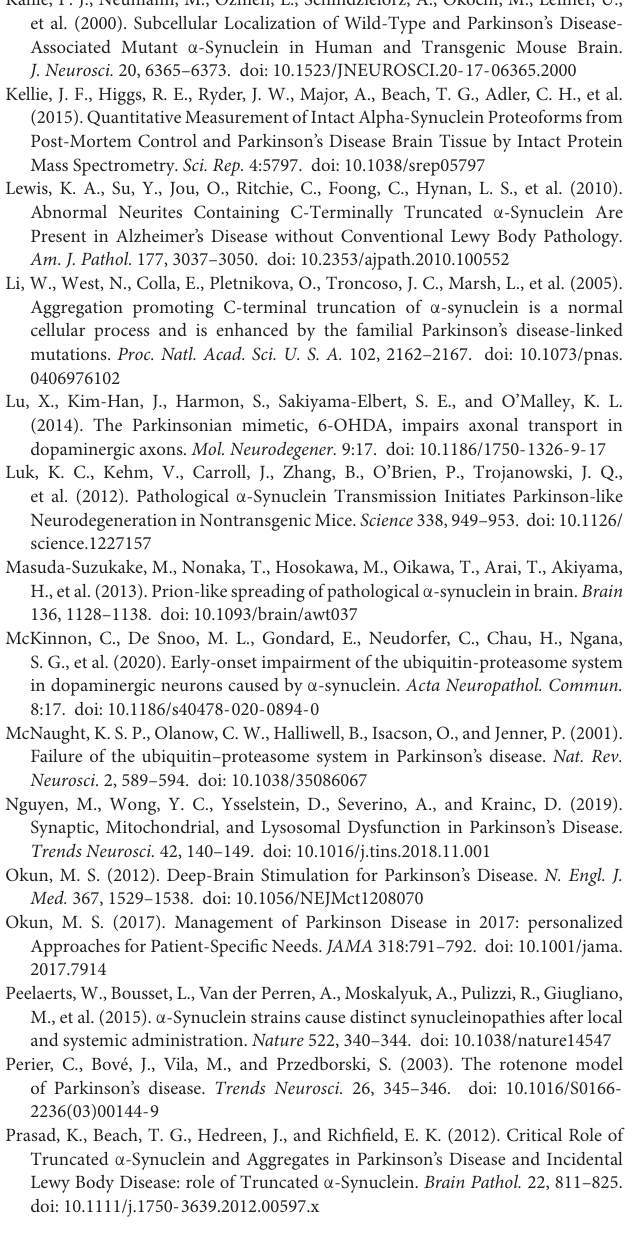
t Cortex = 43.31, t Hippocampus = 4.641, t Striatum = 26.76, t Substantianigra = 47.93, t Cerebellum = 29.96, and t Pons = 34.70, for all P < 0.001). Supplementary Figure 11 | HPLC analysis of the striatal neurotransmitters (DA, DOPAC, and HVA) in N103 mice and WT littermates. Results were expressed as absolute contents (ng/mg). Data are mean ± s.e.m.; samples from n = 3 mice per group; ∗ P < 0.05 and ∗∗∗ P < 0.001 by two-way ANOVA and Bonferroni’s multiple comparisons (for DA, F time = 35.56, F group = 70.88; for DOPAC, F time = 124.6, F group = 210.1; for HVA, F time = 70.38, and F group = 185.7; for all P < 0.001). Supplementary Figure 12 | Behavioral impairment and constipation of N103 mice do not demonstrate gender differences. Open field test (for distance, F time = 8.454, P = 0.0009, F group = 1.922, P = 0.1726; for time mobile, F time = 20.27, P < 0.001, F group = 0.06189, P = 0.8061; for line crossings, F time = 9.005, P = 0.0006, F group = 1.436, P = 0.2372; for rears, F time =